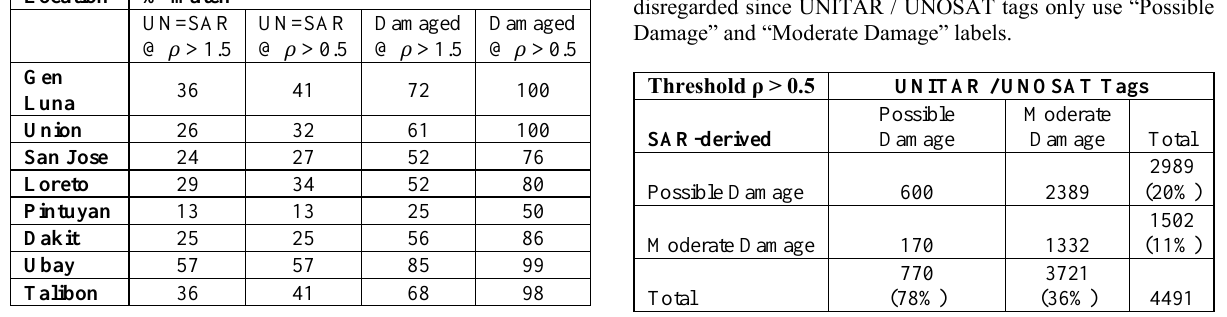
Table 4. Confusion matrix for when threshold for ρ is > 0.5. “No Damage” and “Moderate Damage”